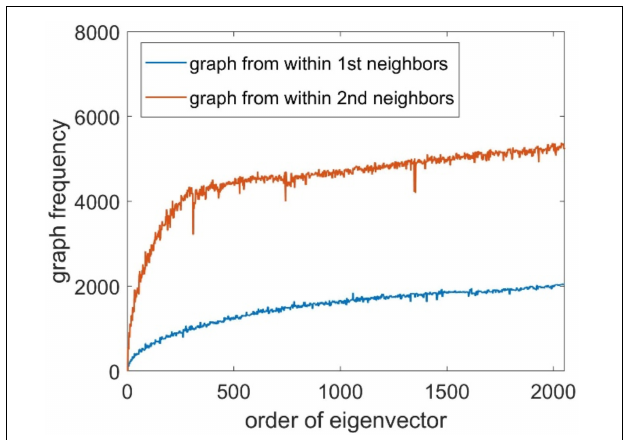
FIGURE 2 | Graph frequency of the